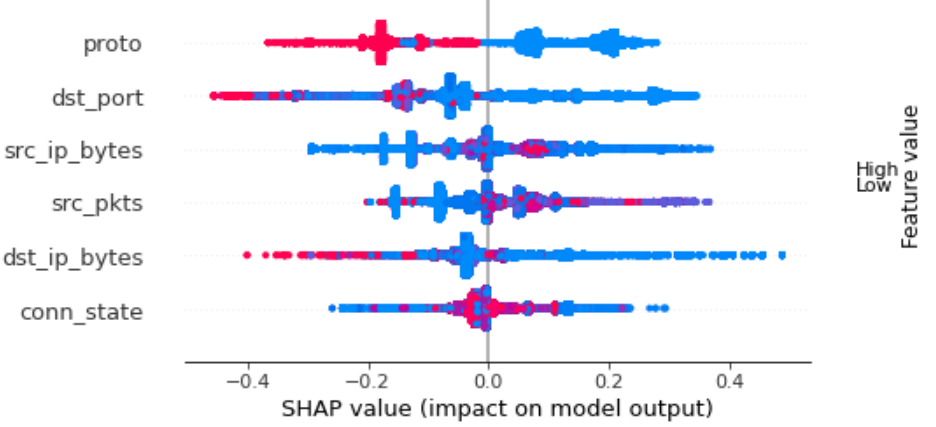
Figure 6. SHAP Values Summary Plot for the Selected